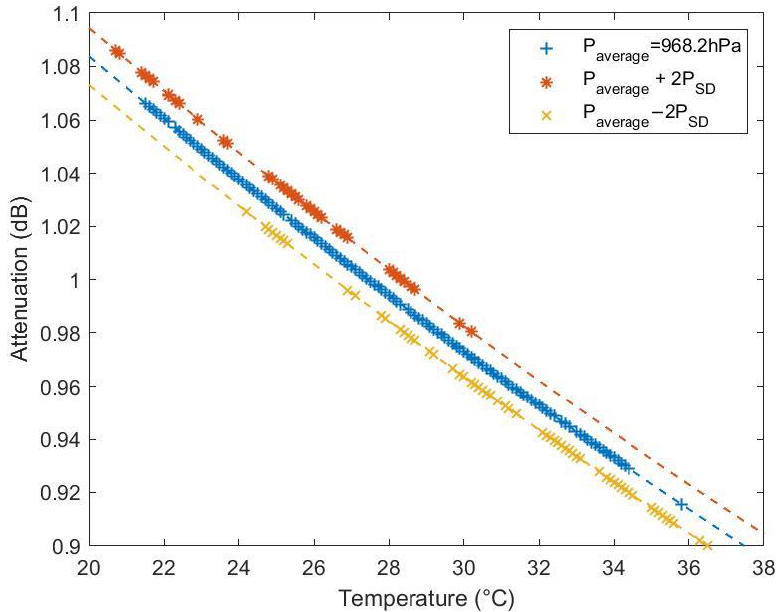
Figure 4. The range of gaseous attenuation calculated from the measured data.